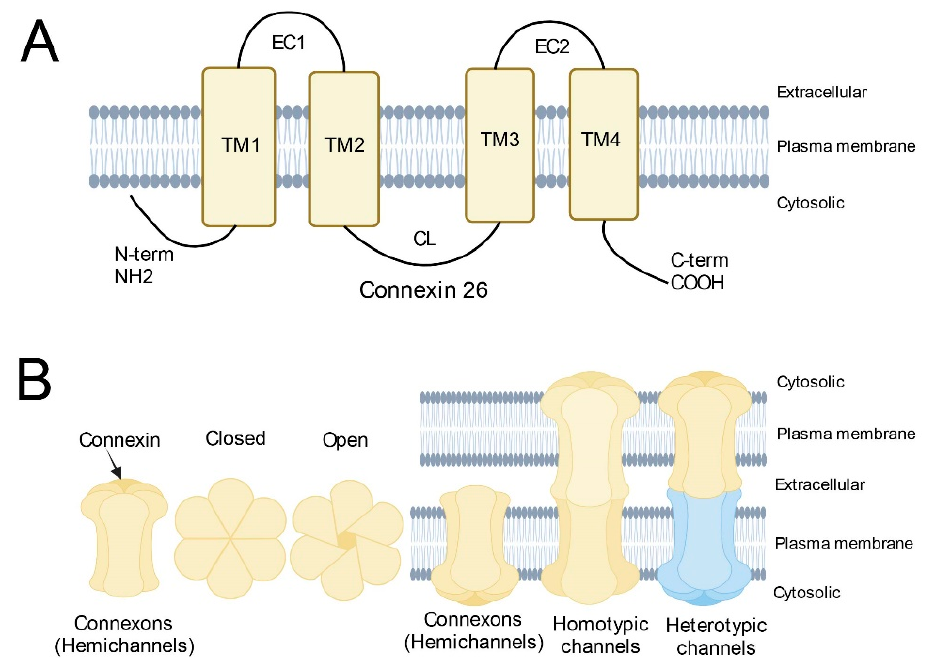
Figure 1. Schematic diagram of Connexins. ( A ) Basic structure of Connexin 26; ( B ) Structure of connexons and (homotypic/heterotypic) gap junction channels. Homotypic gap junction channels are composed of two identical connexons. Heterotypic gap junction channels are composed of two different connexons.